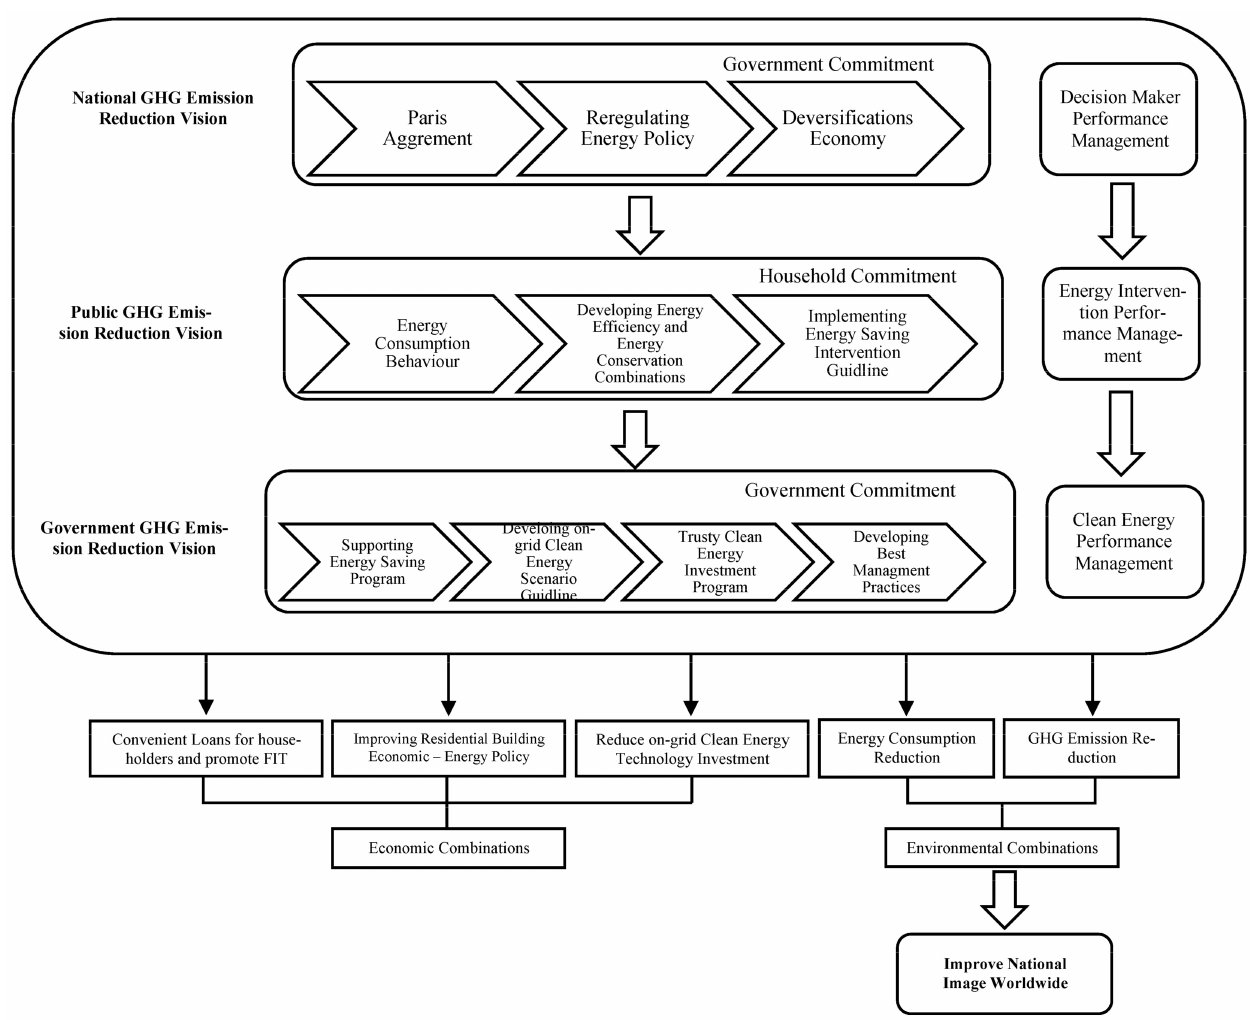
Figure 2. GHG emissions approach roadmap adapted from